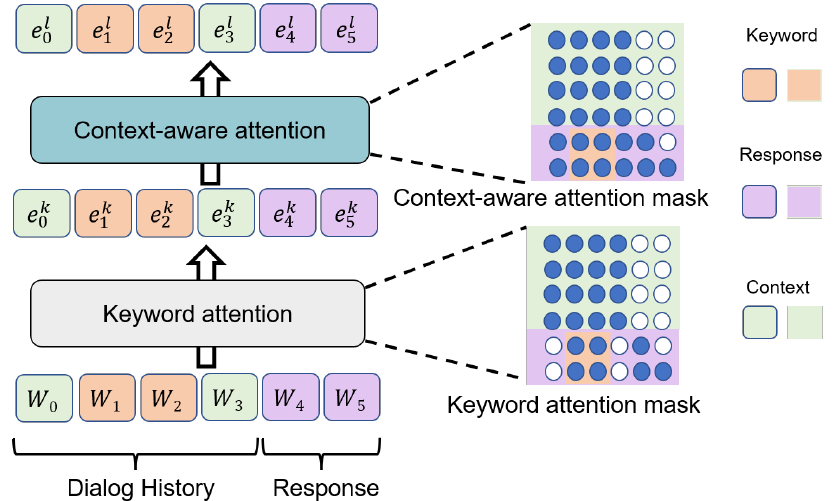
Figure 3. Two types of the proposed attention mechanism, including context-aware attention and keyword attention. The upper right dashed extension shows the specific details of the context-aware attention mask, while the lower right shows the keyword attention mask in